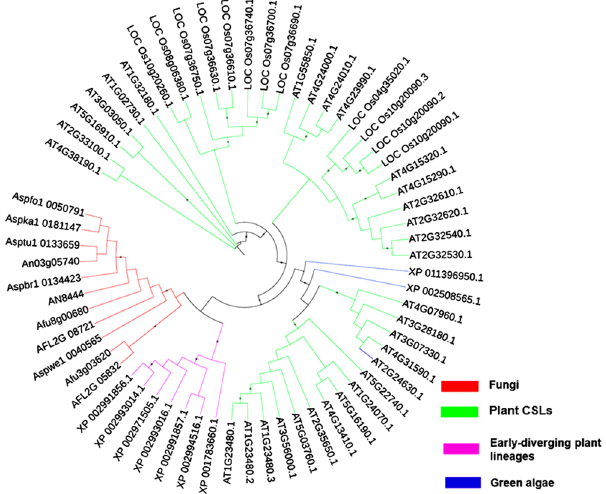
Figure 1. Neighbor-joining tree (bootstraps = 1000) of CelA, its fungal and plant orthologs. Accession numbers are indicated in the